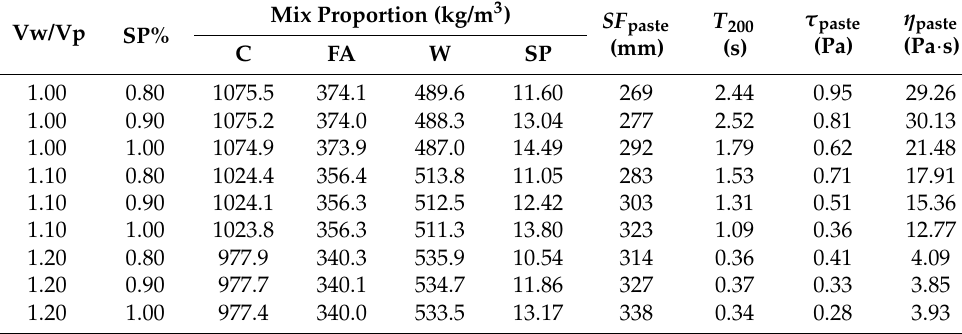
Series 3 contains the same types of powder as series 2, cement and FA. The substitution rate of FA was 30% by volume. The cement, gravel, and sand types were C_A, G_A, and S_A, respectively. The gravel content was 300 L/m 3 , and the sand ratio was 45%. The detailed mix and test results of pastes and SCCs are shown in Tables 8 and 9. τ paste and η paste in Table 8 were calculated by Equations (5) and (6). According to the test results, SCP zones obtained by the original and modified methods were proposed, as shown in the black dashed and solid lines in Figure 7. The SCC zone is shown as the red short dashed line in Figure 7. Table 8. Mix proportions and test results of paste in series